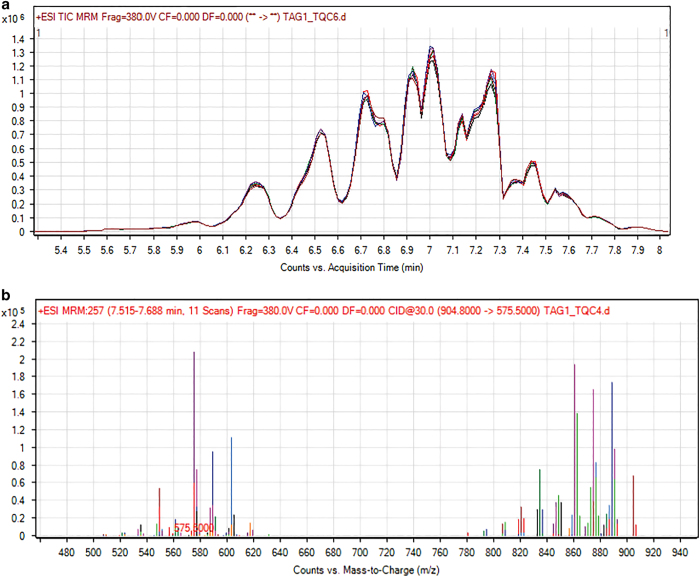
Representative technical quality control and MS spectrum of TAG.(a) Assessing data quality by overlaying six TICs of the technical quality control sample analyzed at regular intervals between the experimental samples. (b) A representative MS spectrum extracted from one of the technical quality control sample showing TAG species counts between 450 m/z and 950 m/z.